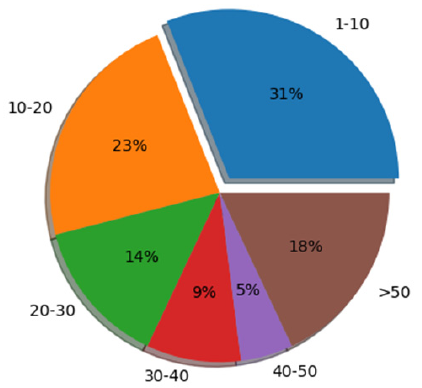
Figure 4. The probability distribution corresponding to different text length